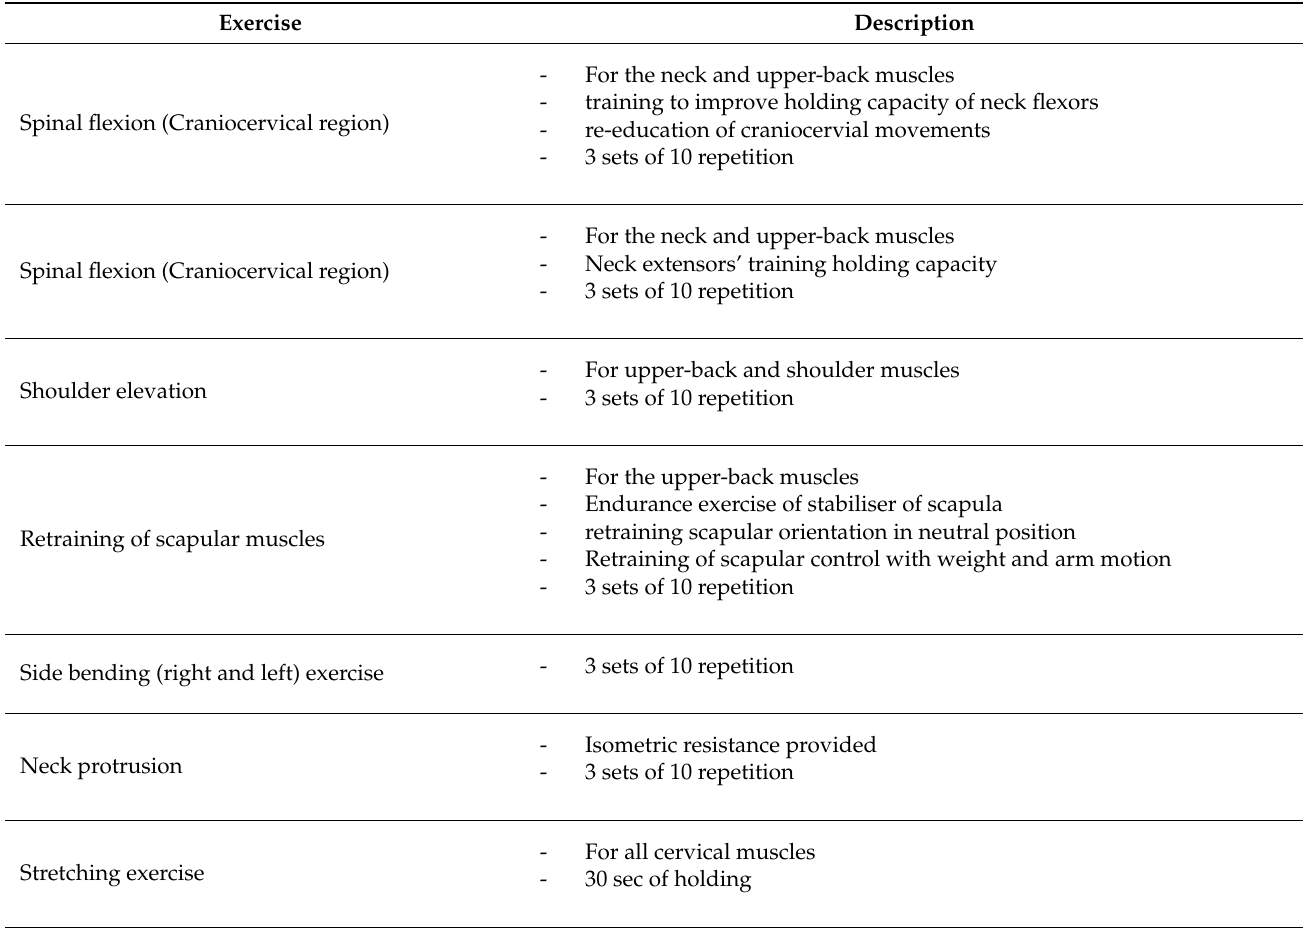
Table 1. Exercise protocol used in the study for both control group and experimental